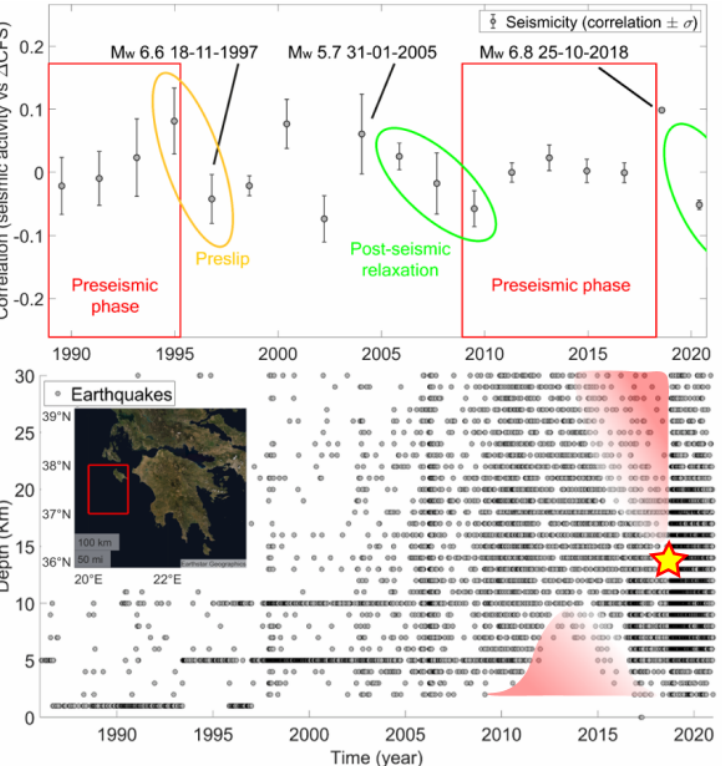
Figure 3. Correlation between ∆ CFS and seismicity close to the Greek Ionian coasts (37.0–38.0° N, 20.0–21.0° E) between 1985 and 2021. A nine-years-long preseismic phase is highlighted both by an increasing value of correlation in the upper part of the picture, and seismic quiescence, represented by two red shadow zones, at a depth of 0–10 km (2012–2017) and >20 km (2015–2018). The yellow star represents the M w 6.8, 25 October 2018 Lithakia